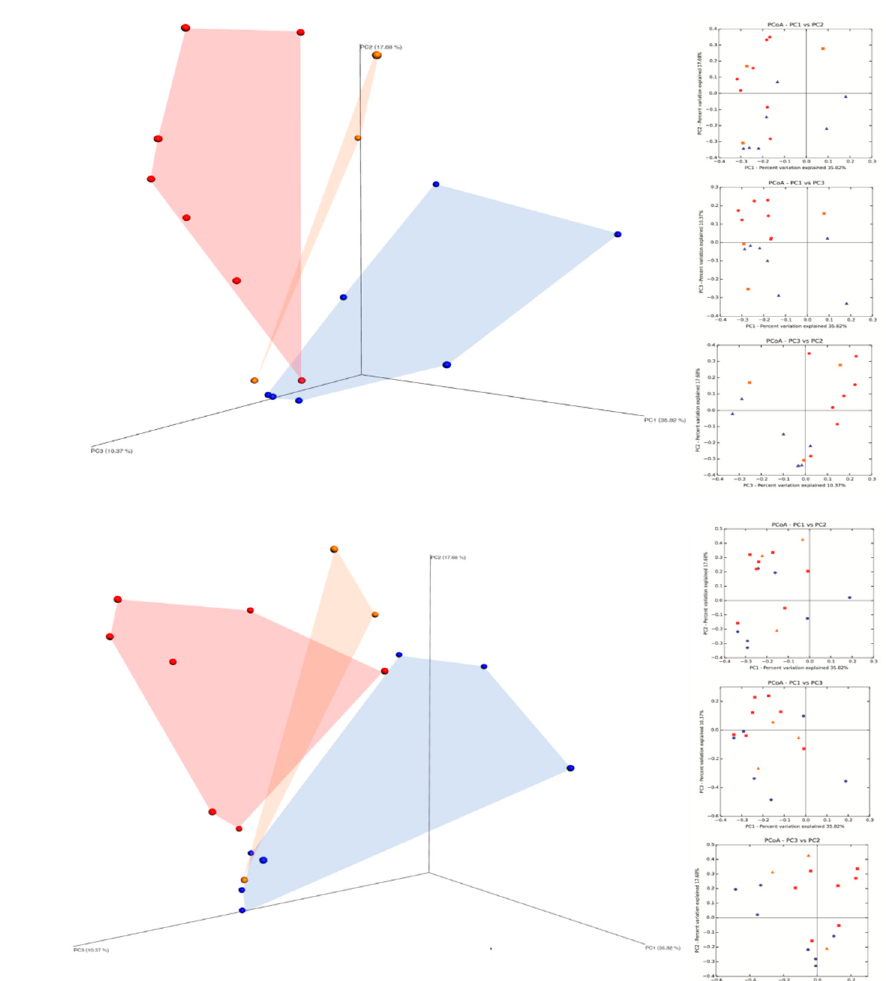
Figure 8. Principal Coordinate Analysis (PCoA) based on the fungal ITS sequences identified in organic (MO) ; conventional (MC) and not treated (MNT) samples at the harvest time ( a ), at 7th day ( b ) and at 15th day ( c ) of spontaneous fermentation. Percentages shown along the axes represent the proportion of dissimilarities captured by the axes.